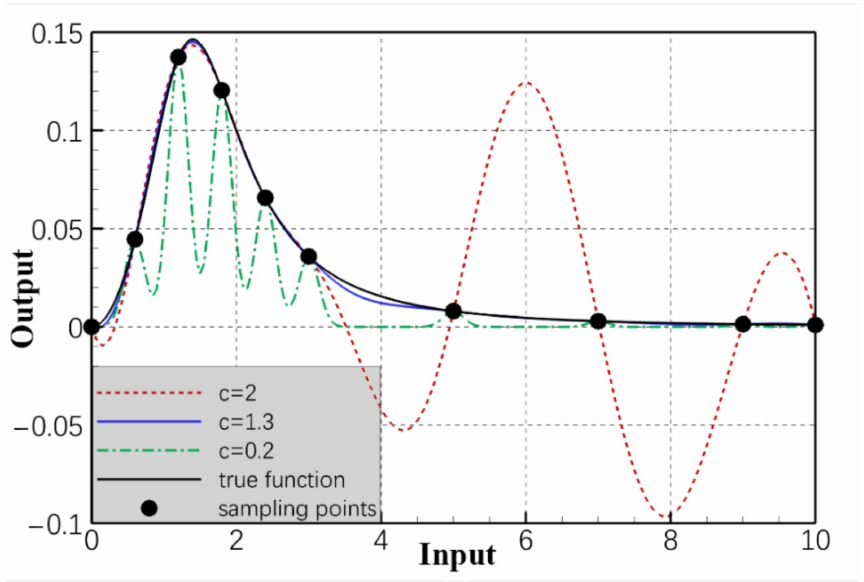
Figure 3. Influence extent of prediction accuracy with respect to the shape